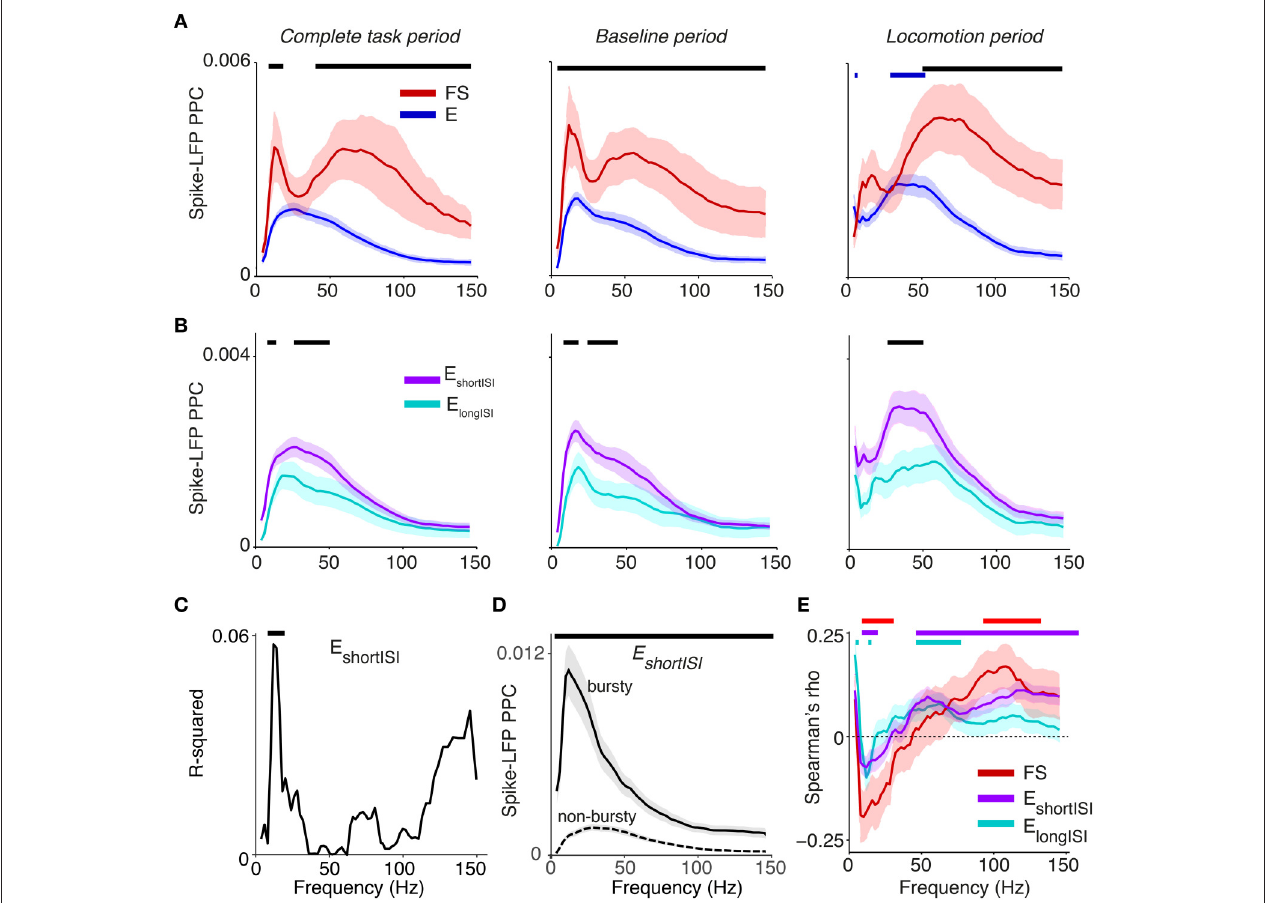
FIGURE 5 | Phase locking of S1BF cells to S1BF LFPs. (A) Mean ± SEM of spike-LFP PPC (Pairwise Phase Consistency) as a function of frequency (Hz), separately for FS and E cells. Left: PPCs were computed over all recorded spikes in a window of ± 10s around cue onset. Middle and right column correspond to baseline and locomotion period, respectively. Black significance bars indicate significant differences between FS and E cells. Blue bars indicate significance of phase locking difference relative to baseline period for E cells (multiple comparison corrected randomization test, Korn et al., 2004). Besides a gamma peak, the PPC spectra show beta peaks around 12–20Hz. (B) Same as (A) , but now for E longISI and E shortISI cells. (C) Increase in R-squared (explained variance) by adding the LV to a multiple regression model, in which we predict PPC-values (measured in entire task period) from LV and log 10 firing rates for E shortISI cells. Black bars indicate significance of regression coefficient ( p < 0.05, FDR corrected for number of frequencies). (D) Mean ± SEM of PPC spectra (measured in entire task period) for bursty E shortISI cells and non-bursty firing E shortISI cells. We identified these cells using fuzzy c-means clustering on the distribution of LV-values, with 0.95 probability membership cut-offs. Black bars indicate significance of phase locking difference (multiple comparison corrected, Korn et al., 2004). (E) Spearman’s ρ between a cell’s average spike density at time t , computed in a window of 2s, and its PPC-value at time t , across time-points. This correlation was computed for each cell separately, taking the − 10 to 10s period relative to cue onset. Spearman’s ρ -values were then averaged across cells. Shown are means ± SEMs. Horizontal bars indicate significance at p < 0.05 for each cell